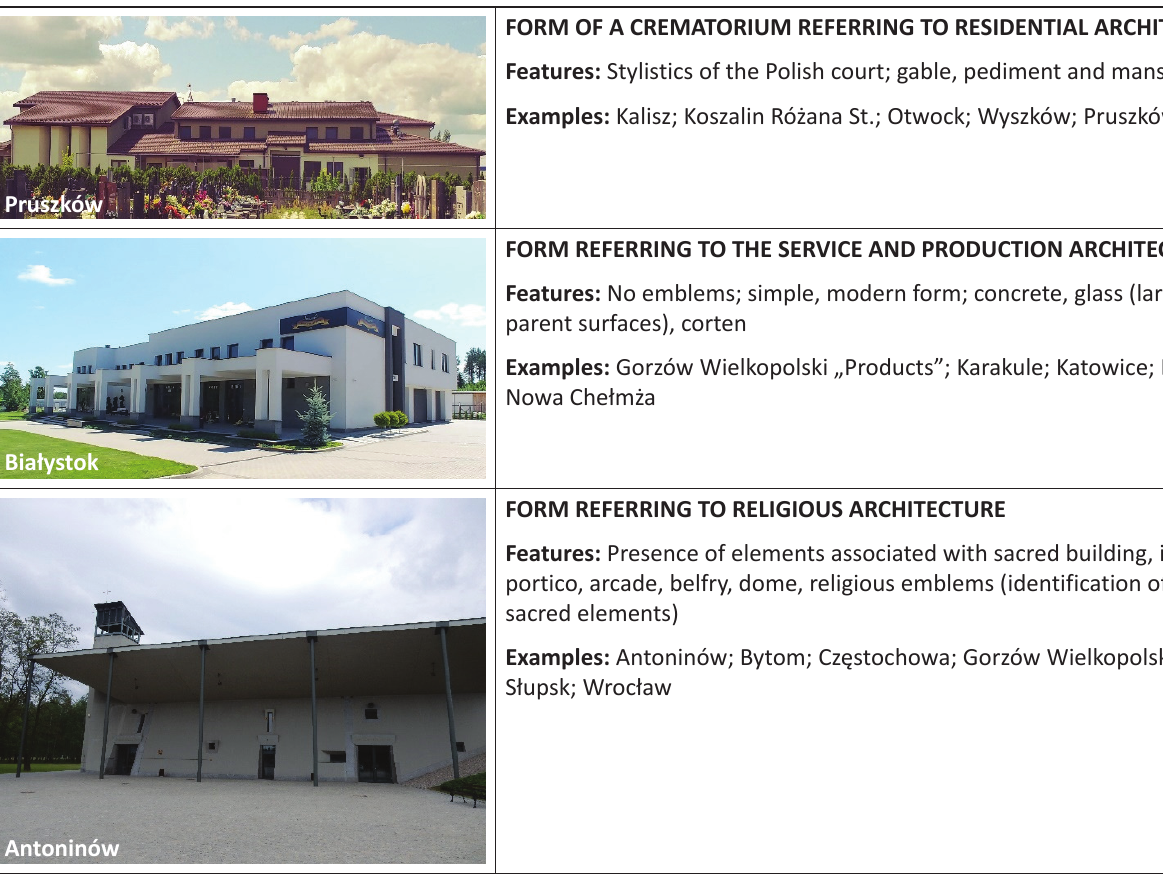
Table 7. List of architectural types of crematoria in Poland. Own